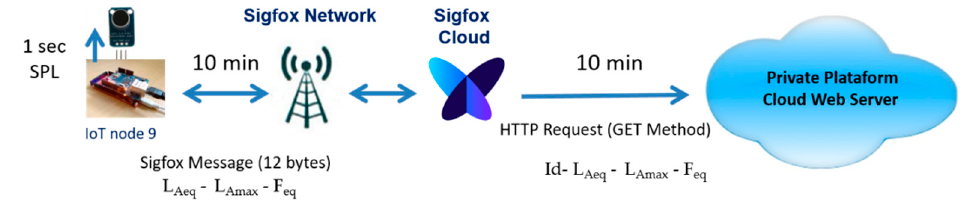
Figure 9. The Sigfox message. HTTP request—GET method.